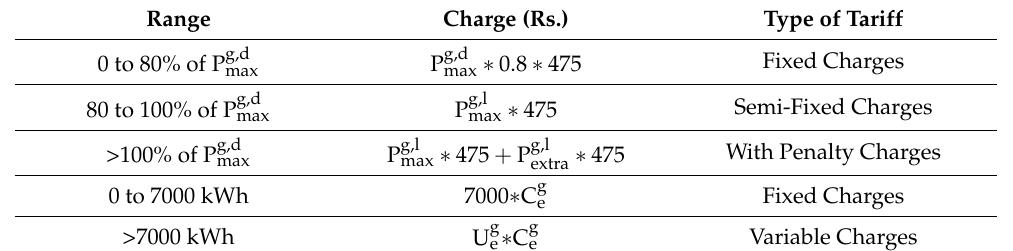
Table 1. Grid tariff structure. Range Charge (Rs.) Type of